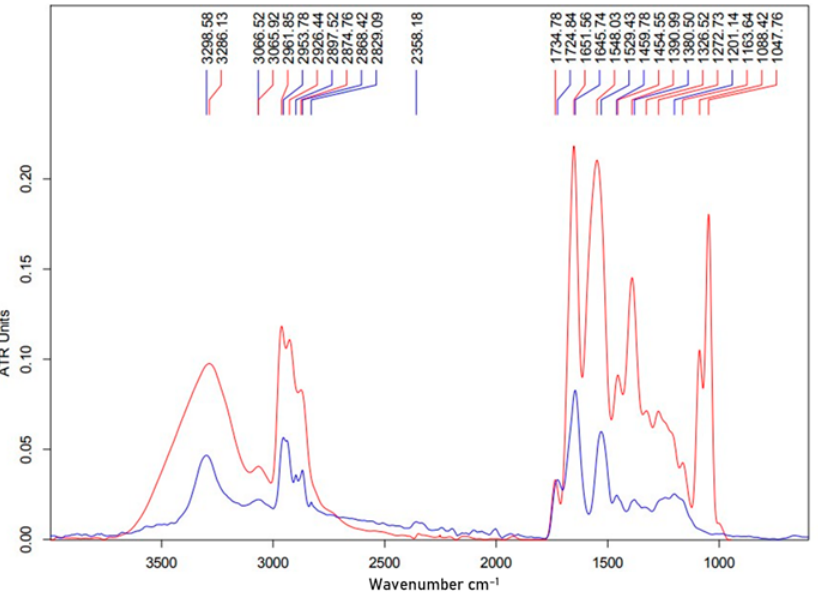
Figure 3. FTIR spectra of the APF produced by B. mojavensis P1709 (blue) and of the surfactin standard (red) (Sigma Aldrich, Darmstadt,